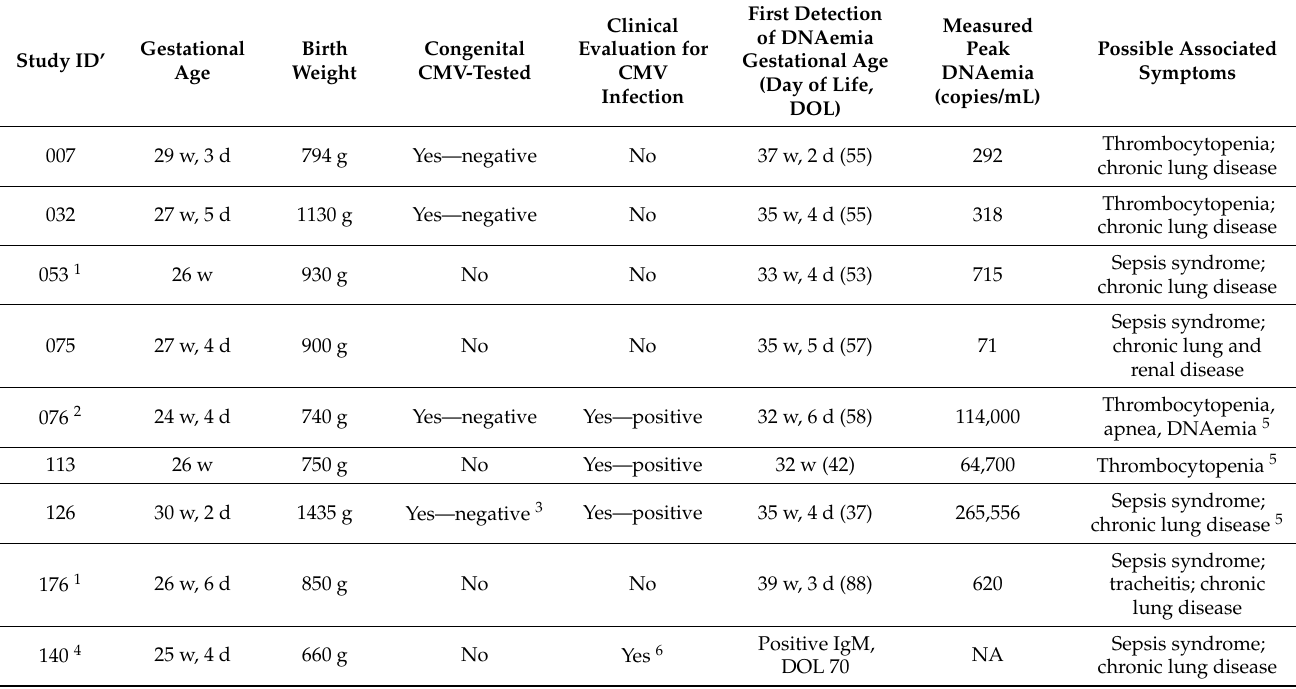
Table 6. Characteristics of infants with post-natal infection ( n = 9) and signs and symptoms compatible with infection. Infants 053 and 176 each had a twin that tested negative for CMV by whole blood PCR and